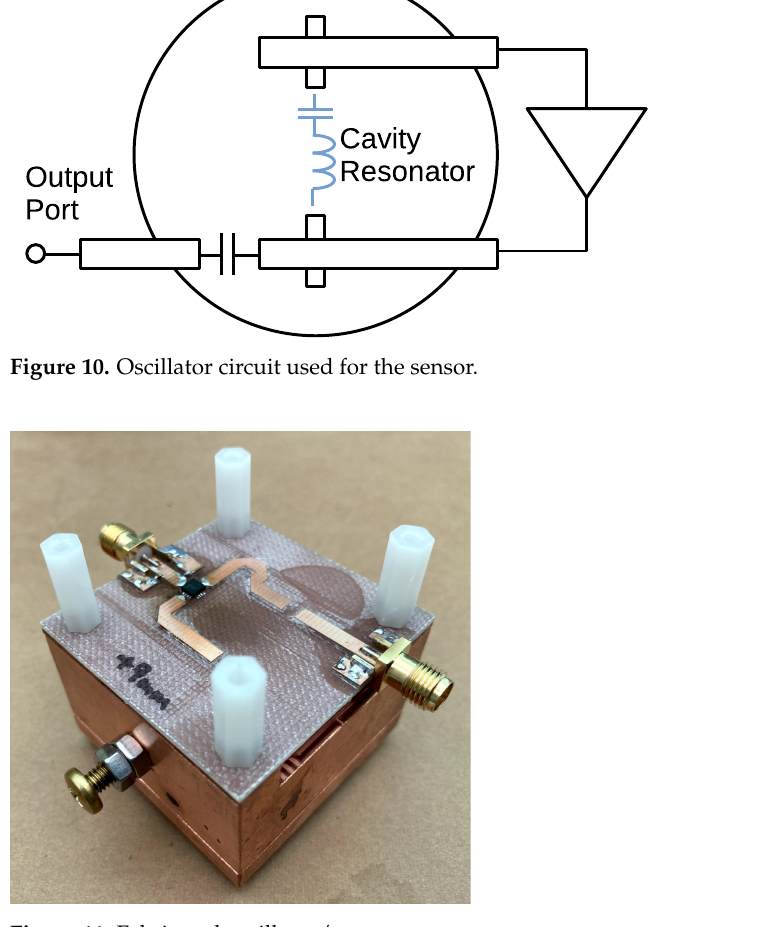
Figure 11. Fabricated